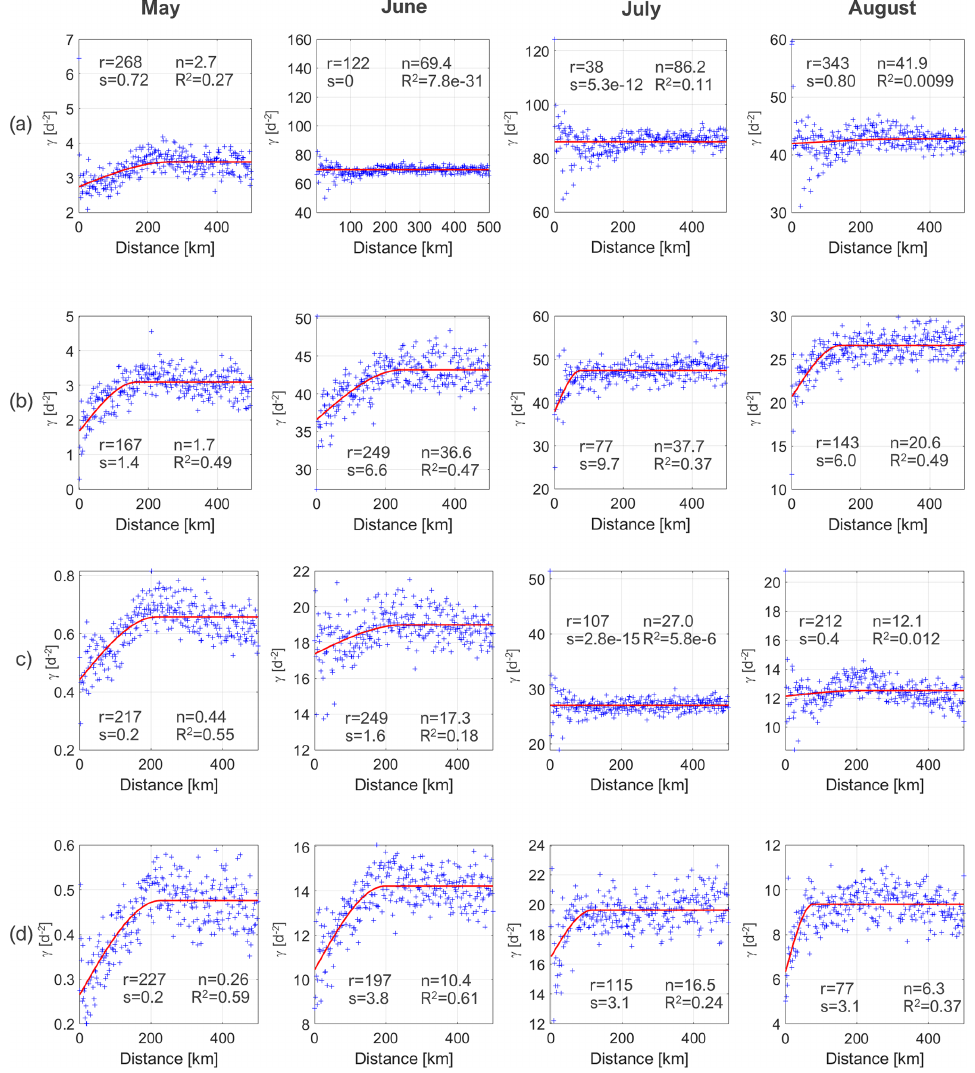
Figure 11. Empirical (blue crosses) and modeled (red line) semi-variograms for the Greenland melt duration (MD) computed by applying the (a, b) MEMLS and (c, d) 245K algorithms to both the (a, c) 25km and (b, d) 3.125km resolution data for each month of the melting season (May, June, July and August). The range ( r ), sill ( s ), nugget ( n ) and R 2 values are reported.